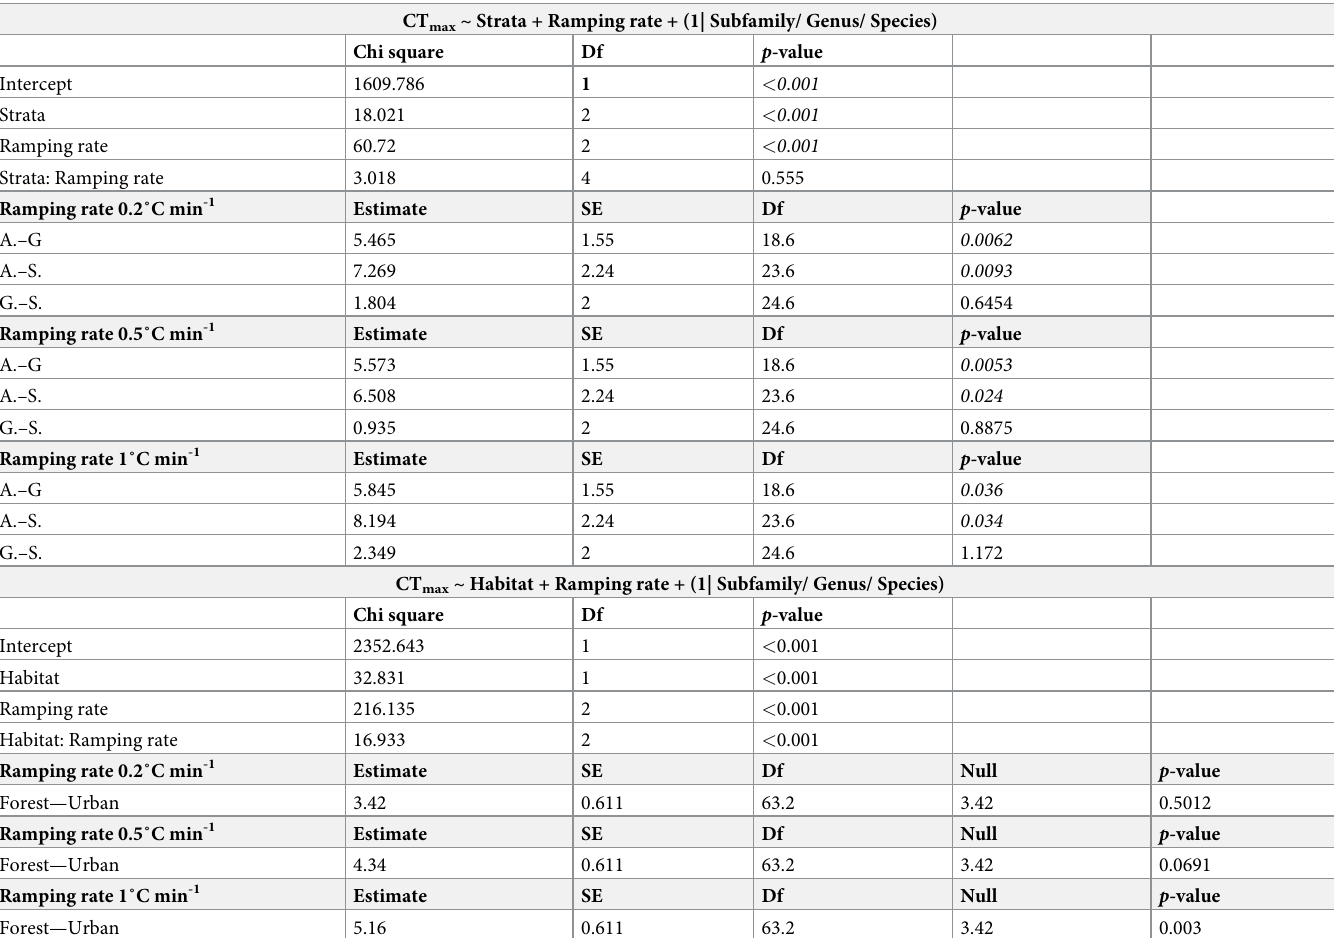
Table 4. Comparison of species CT max values from habitats and microhabitats respectively, the linear mixed models examine the relationship between parameters (CT max , ramping rate and species identity) by linear mixed model for the dynamic assay with white-adjusted p -value; with species identify nested within genus and subfamily